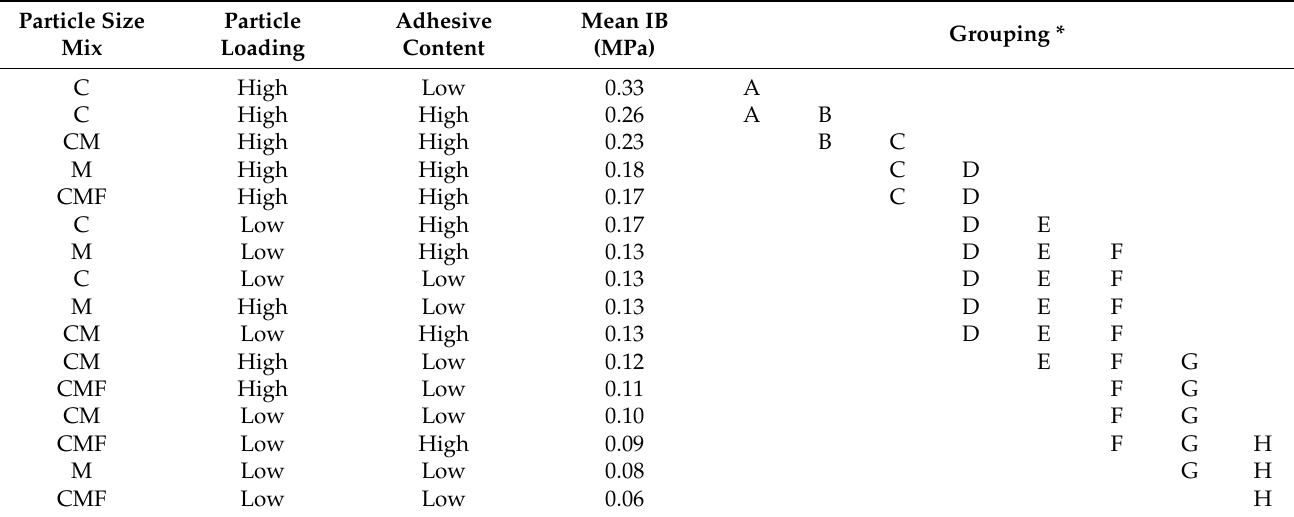
Table A3. Fisher LSD grouping information at 95% confidence level of epoxy-ULHPB. Particle Size